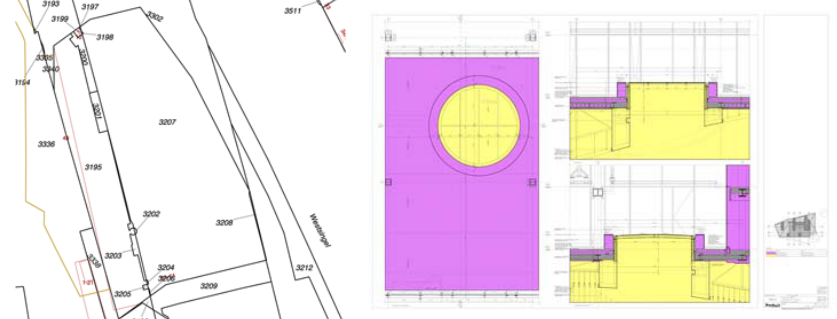
Figure 3. 2D cadastral map of the building complex in Delft ( left ); and registration of rights for a volume by a 2D description in the deed ( right ).